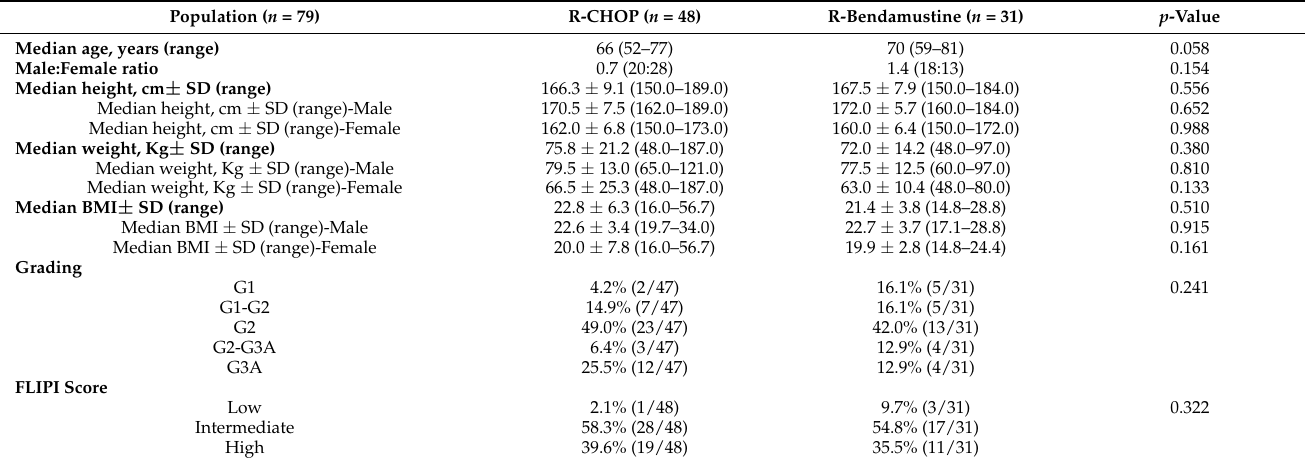
Table 1. Presentation characteristics stratified by R-CHOP vs. R-Bendamustine